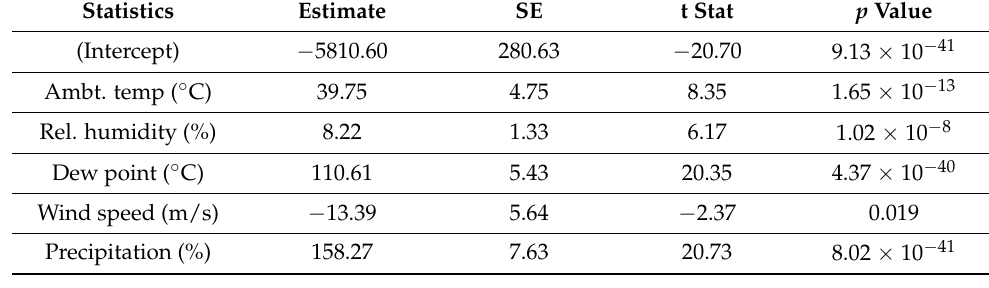
Table 4. Final regression results for irradiance prediction.